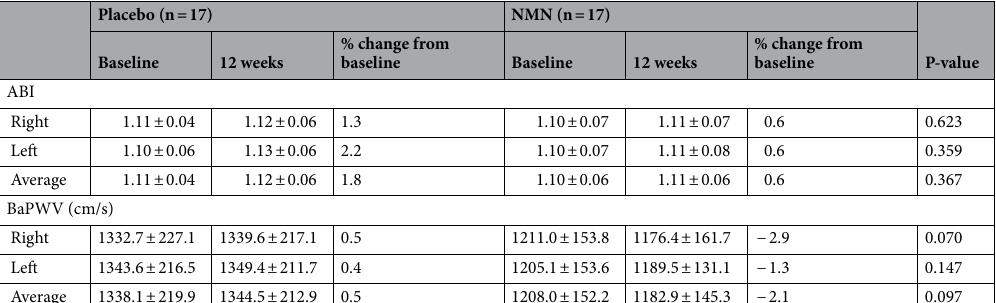
Placebo (n = 17) NMN (n = 17)